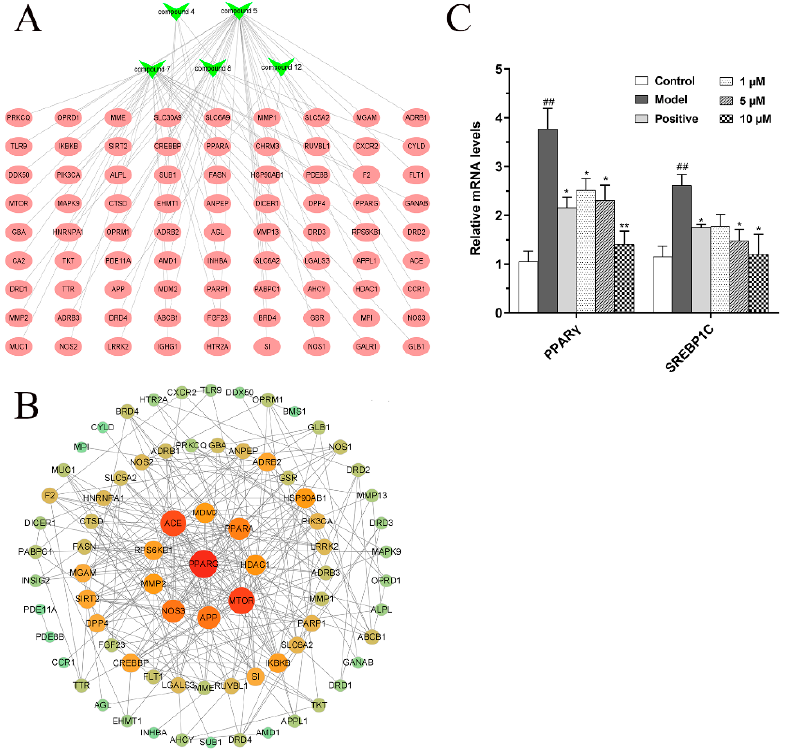
Figure 8. Underlying mechanism study of five isolated compounds based on network pharmacology method. ( A ) Component–target network diagram; ( B ) Protein interaction (PPI) network diagram. ( C ) The effects of compound 12 on fatty acid synthesis in FFA-induced BRL cells. ## p < 0.01, vs. the control group; * p < 0.05, ** p < 0.01, vs. the model group.